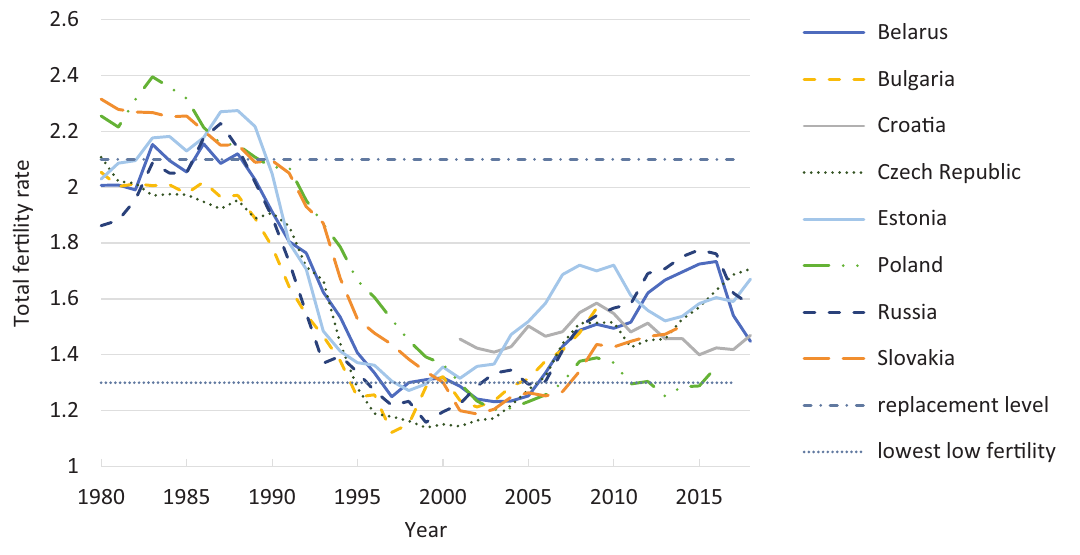
Figure 1. TFRs in selected CEE countries,